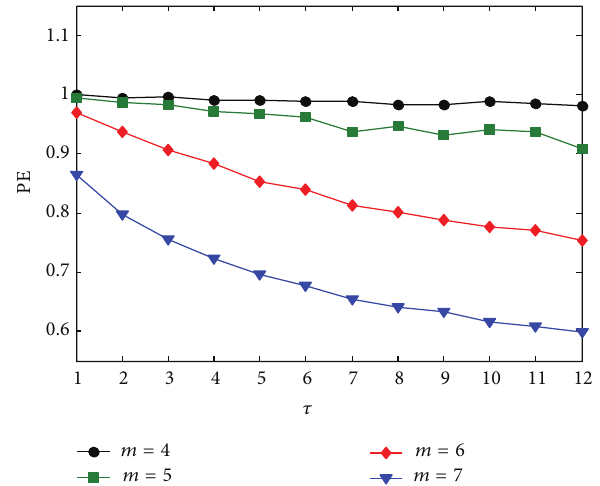
Figure 4: Flow chart of the proposed